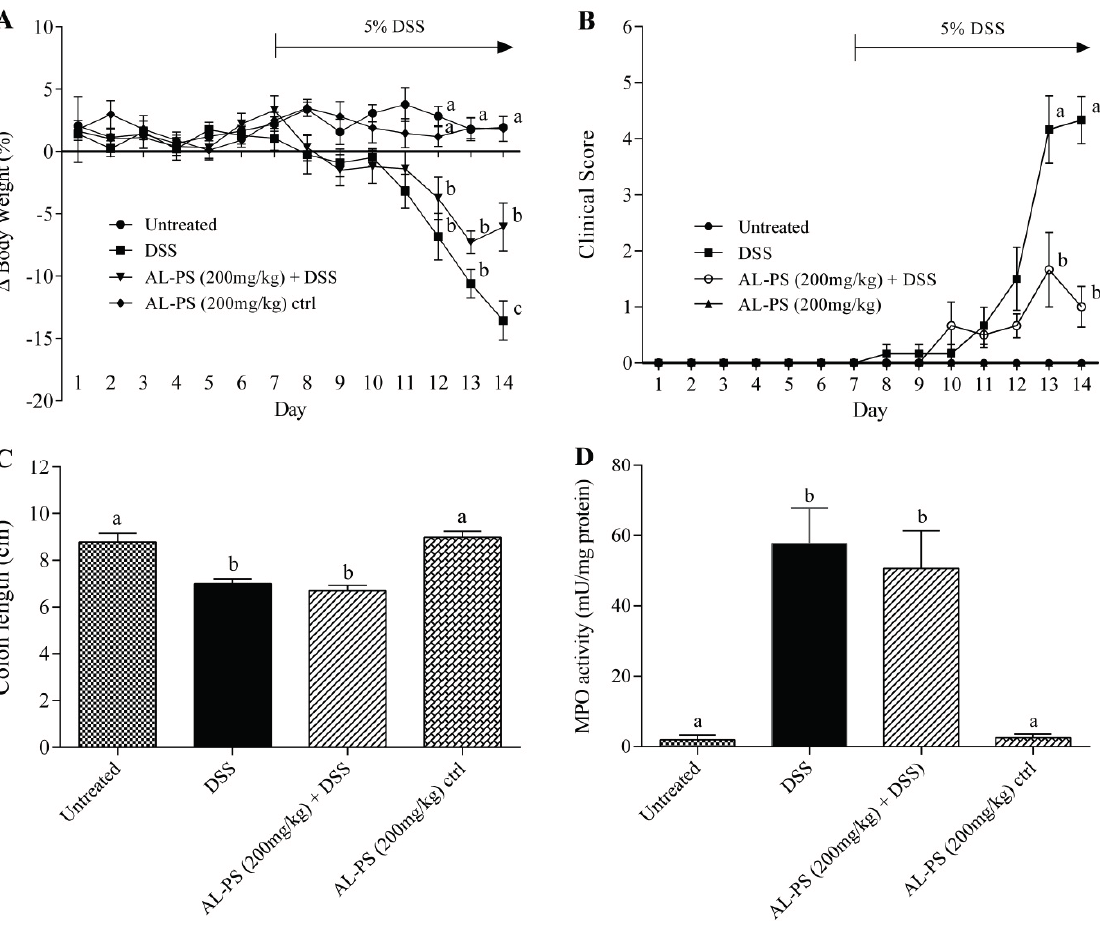
Figure 2. Effect of AL-PS on ( A ) daily weight loss; ( B ) daily clinical signs; ( C ) colon length; and ( D ) MPO activity in DSS-induced colitis. Mice were given 200 mg/kg BW of AL-PS daily for 14 days. From day 7, colitis was induced by 5% DSS in drinking water. Weight loss was calculated as percentage change relative to day 0. Colons were measured from the end of the cecum to the anus. Data represent means ± SEM of n = 6 mice/group. Different letters indicate statistically significant differences at p < 0.05. Unless indicated, no significant difference was observed between